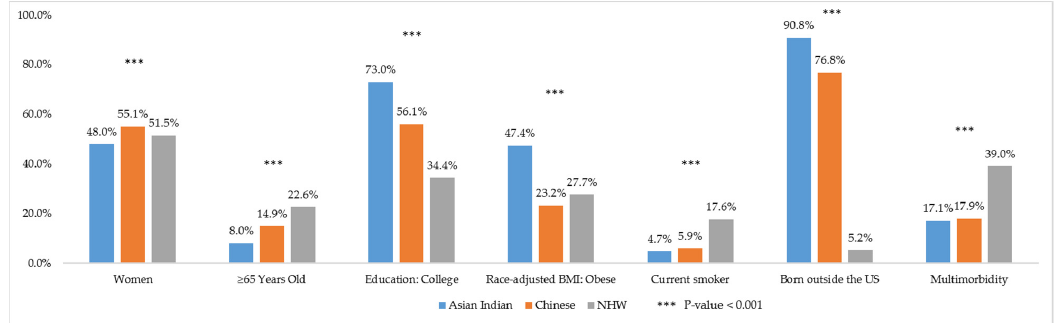
Figure 1. Selected sample characteristics in weighted % among Asian Indian, Chinese, and Non-Hispanic White adults (age ≥ 18 years). National Health Interview Survey, 2012–2017. Table 1. Unweighted N and weighted % of characteristics among Asian Indians, Chinese and Non-Hispanic White (NHW) adults (age ≥ 18 years). National Health Interview Survey, 2012–2017.